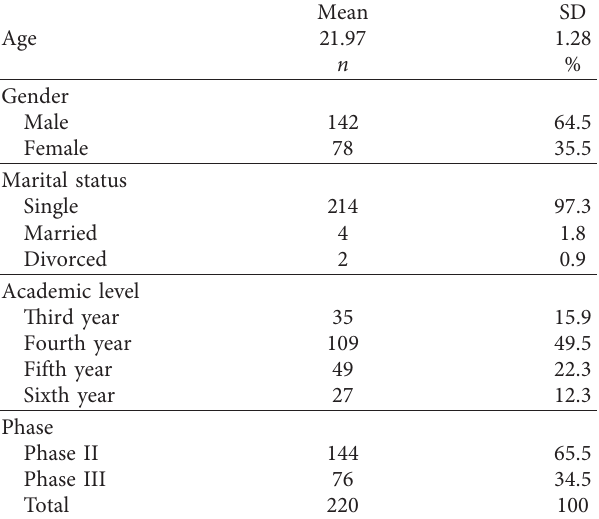
Table 3: Demographic characteristics of student